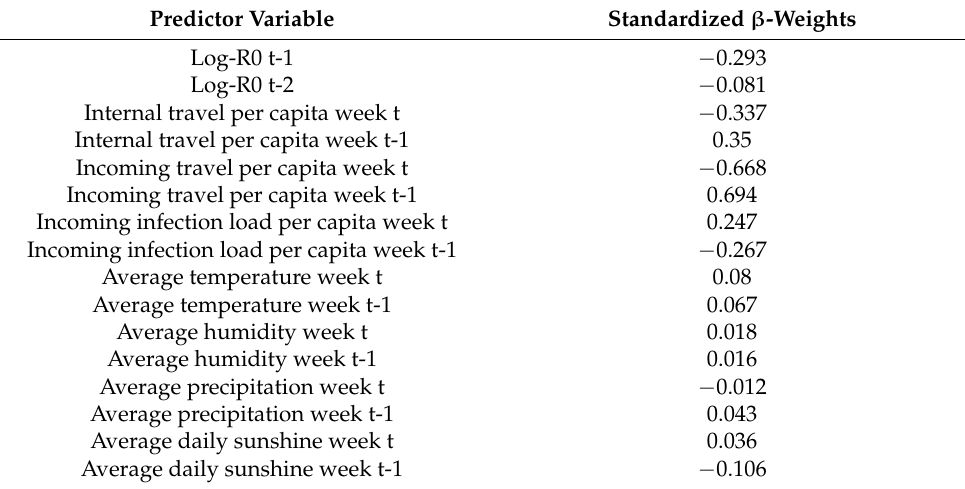
Table A1. Regression weights from the ARX(2,2). Standardized to range [ − 1, 1]. Predictor